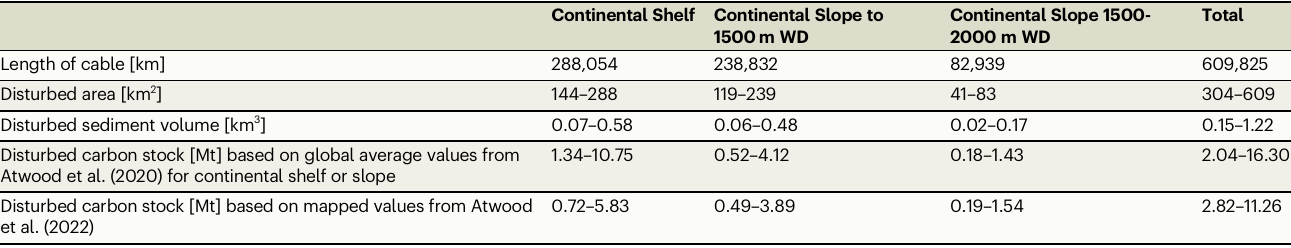
Table 1 | Length, area and volume of potentially disturbed sediment and organic carbon by cable burial